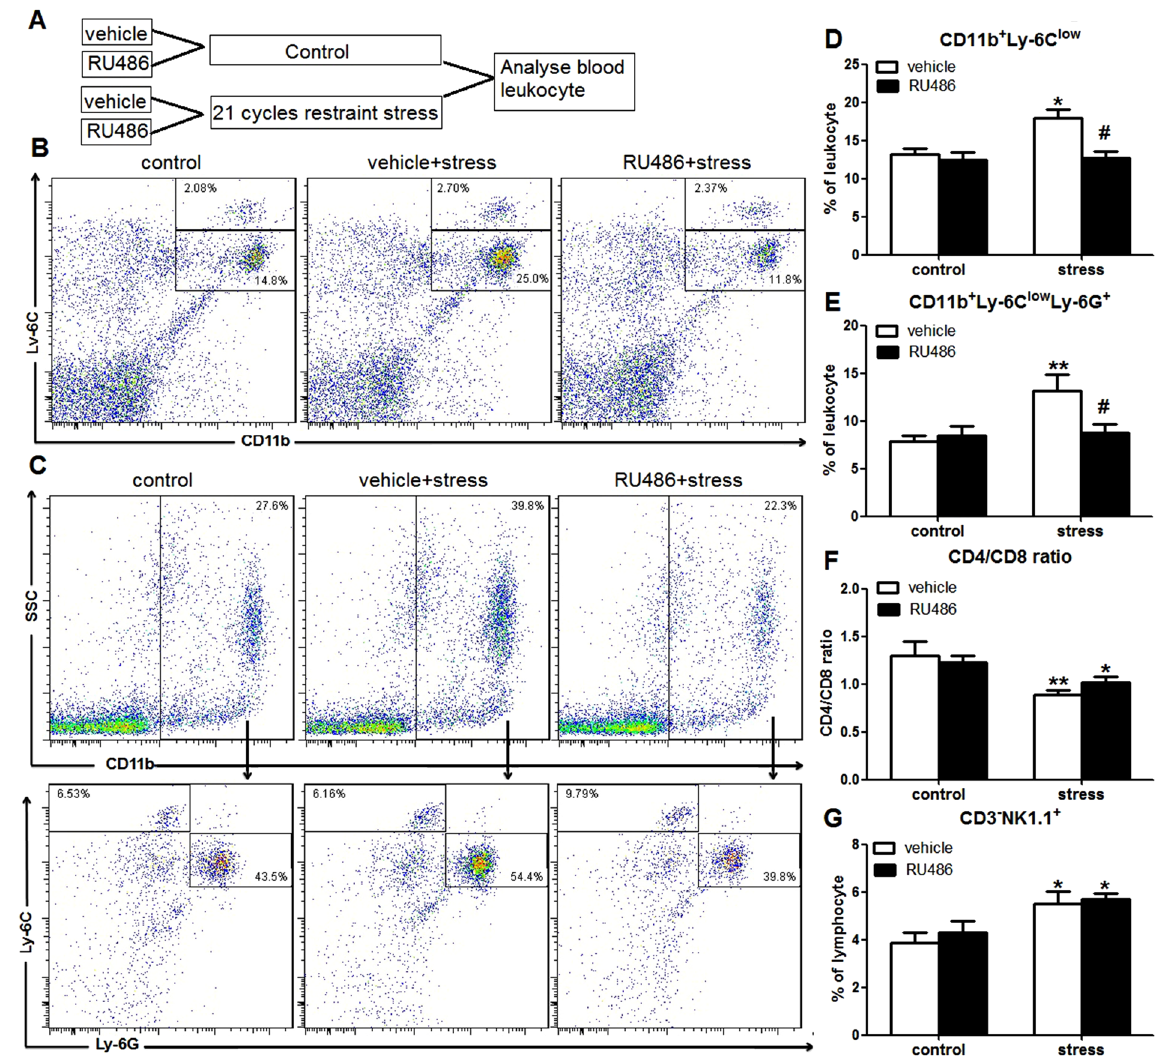
Figure 4. RU486 could attenuate the increase of the percentages of CD11b + Ly-6 low monocytes and CD11b + Ly- 6C low Ly-6G + PMN-MDSCs induced by restraint stress. ( A ) Mice were injected sc with vehicle or RU486 prior to restraint stress each day for 21 days. ( B and C ) Representative plots of CD11b + Ly-6 low monocytes ( B ) and CD11b + Ly-6C low Ly-6G + PMN-MDSCs ( C ) in blood. ( D and E ) The increased percentages of CD11b + Ly-6 low monocytes ( D ) and CD11b + Ly-6C low Ly-6G + PMN-MDSCs ( E ) were blocked by RU486. ( F and G ) RU486 could not attenuate the changes of the CD4/CD8 ratio ( F ) and the percentages of NK cells ( G ). Data were shown as mean ± SEM (n = 5). * p < 0.05, ** p < 0.01 vs. control. # p < 0.05 vs.